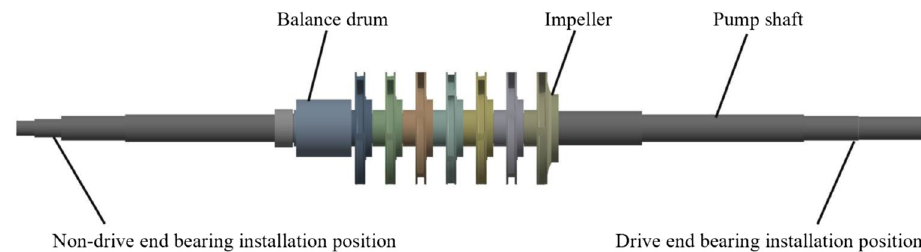
Figure 2. Rotor model of the centrifugal